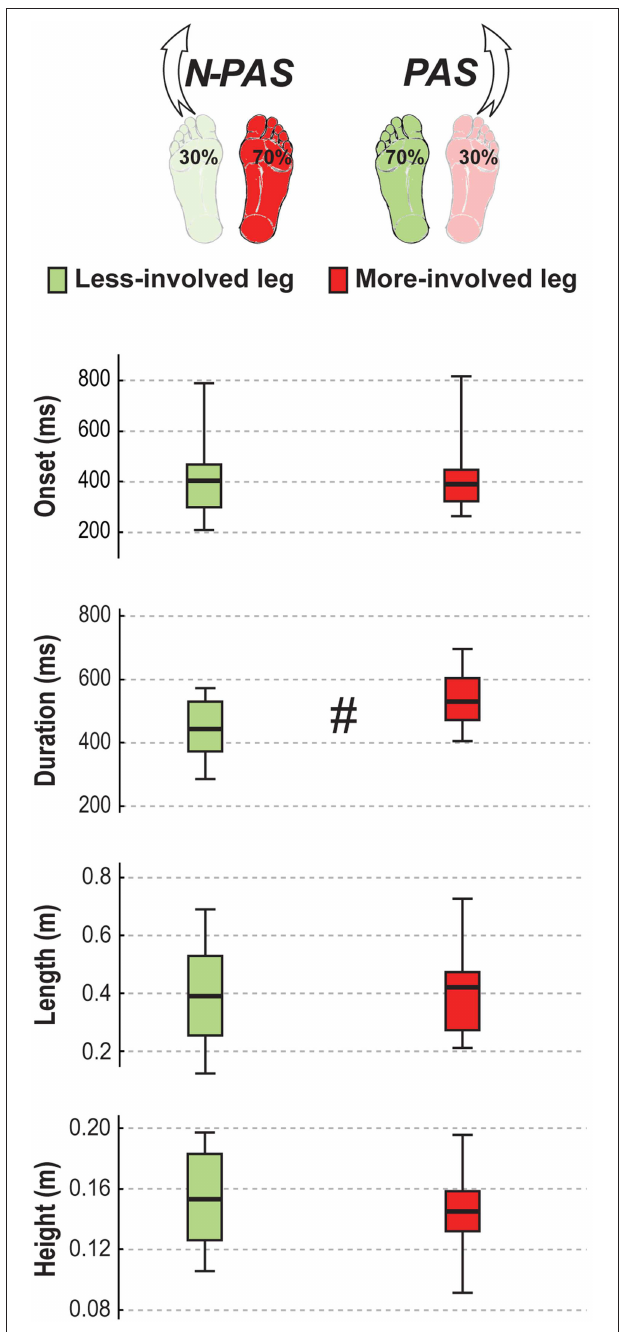
FIGURE 8 | Step characteristics in stroke. The median (thick line) of the step characteristics is presented for the stroke participants when stepping with the less-involved leg in the non-preferred stance condition (N-PAS) and with the more-involved leg in the preferred stance condition (PAS). Boxes represent 25 and 75th percentile. Bars represent min and max values. # Indicates a difference between leg at p <